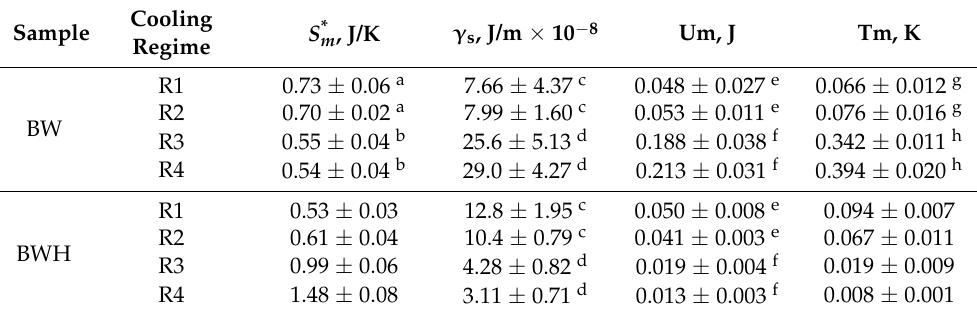
Table 2. Microstructure thermodynamic